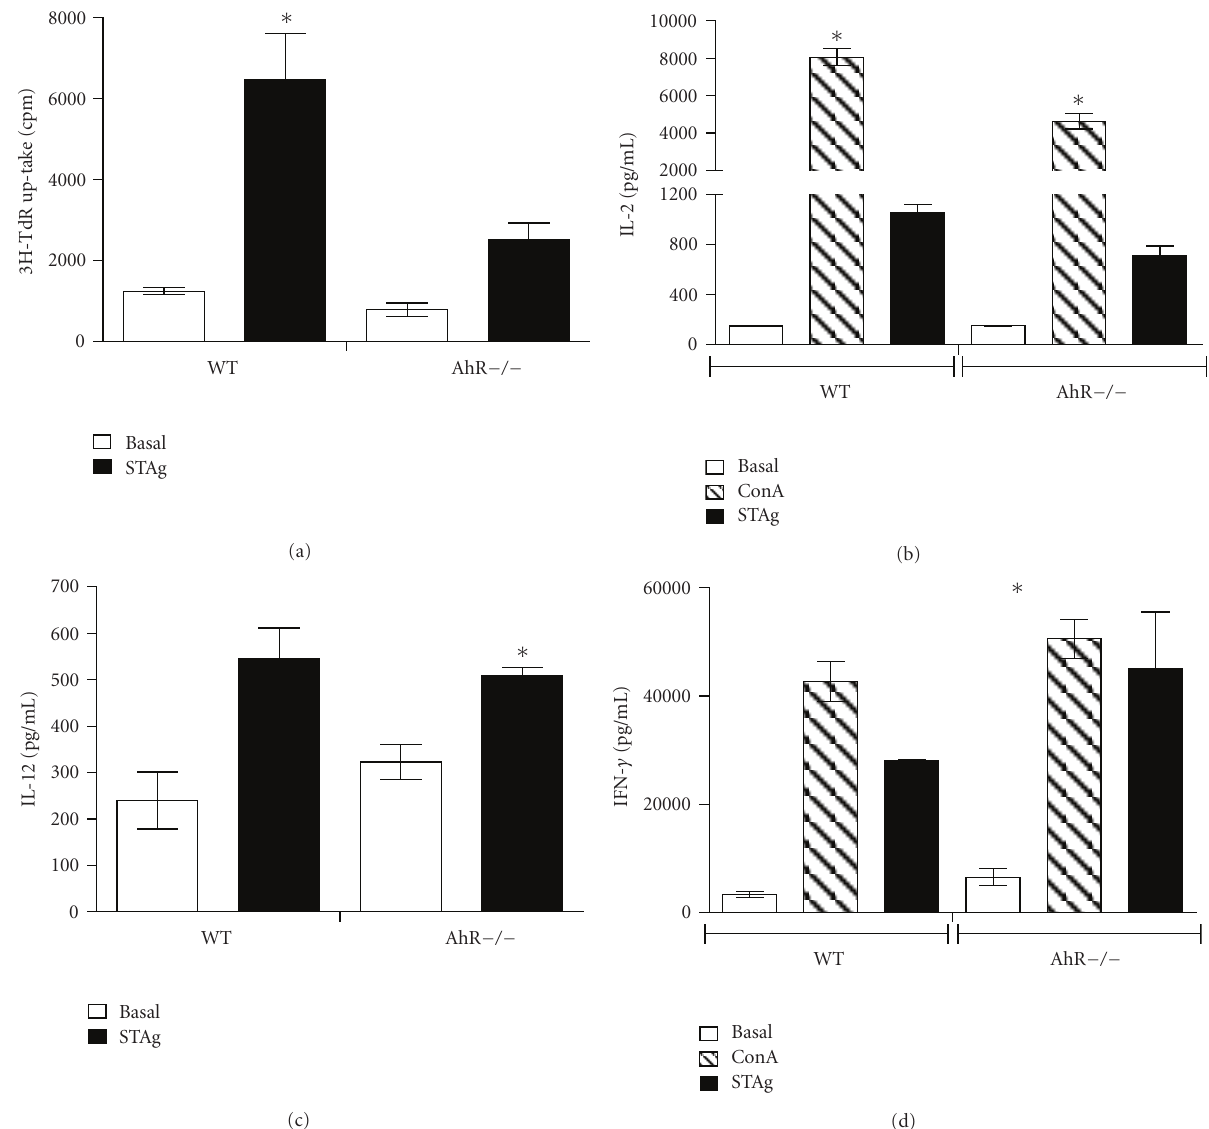
Figure 4: STAg-induced proliferative responses of spleen cells. Isolated spleen cells from T. gondii -infected (25 days p.i.) WT or AhR-/- mice were stimulated with 2.5 μ g/mL of STAg for 5 days in vitro. 3 [H]TdrU was added (0.5 μ Ci/well) 20 hours before harvesting, and counts per minute (cpm) were calculated using a liquid scintillation counter (a). Secretion of IL-2 (b), IL-12 (c), and IFN- γ (d) in supernatants recovered from cell cultures were evaluated by an ELISA-sandwich. Means + SE, n = 5 . ∗ P < . 05, Student’s t